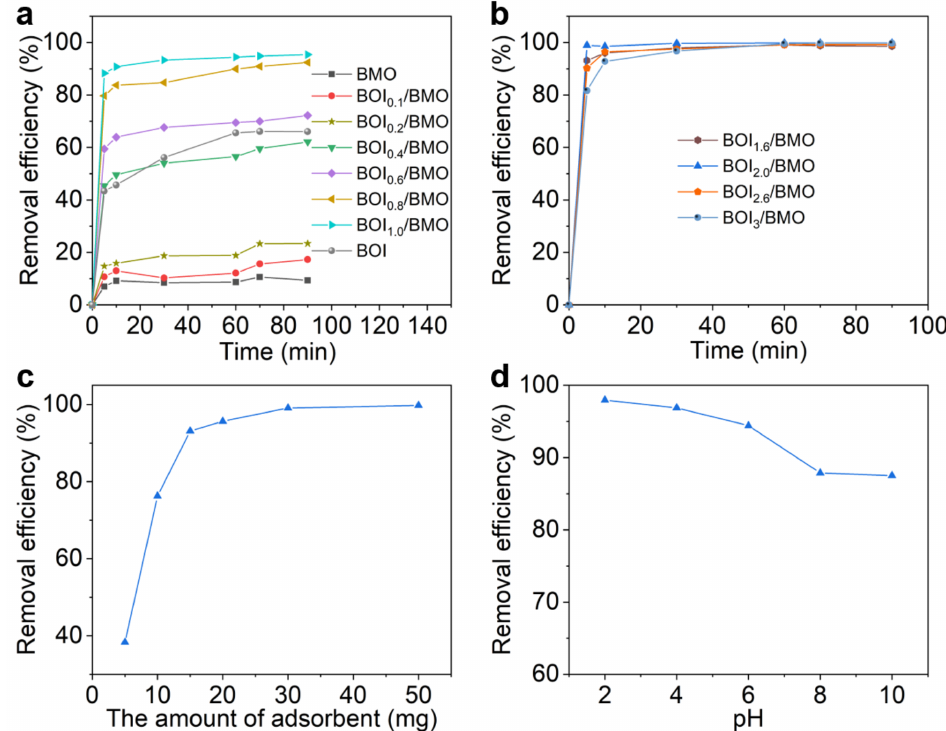
Figure 4. Dark adsorption of RhB (10 mg/L) by ( a ) BMO, BOI, BOI 0.1–1.0 /BMO, and ( b ) BOI 1.6–3.0 /BMO (50 mg) over time. Effect of ( c ) adsorbent quantity and ( d ) pH on RhB removal by BOI 2